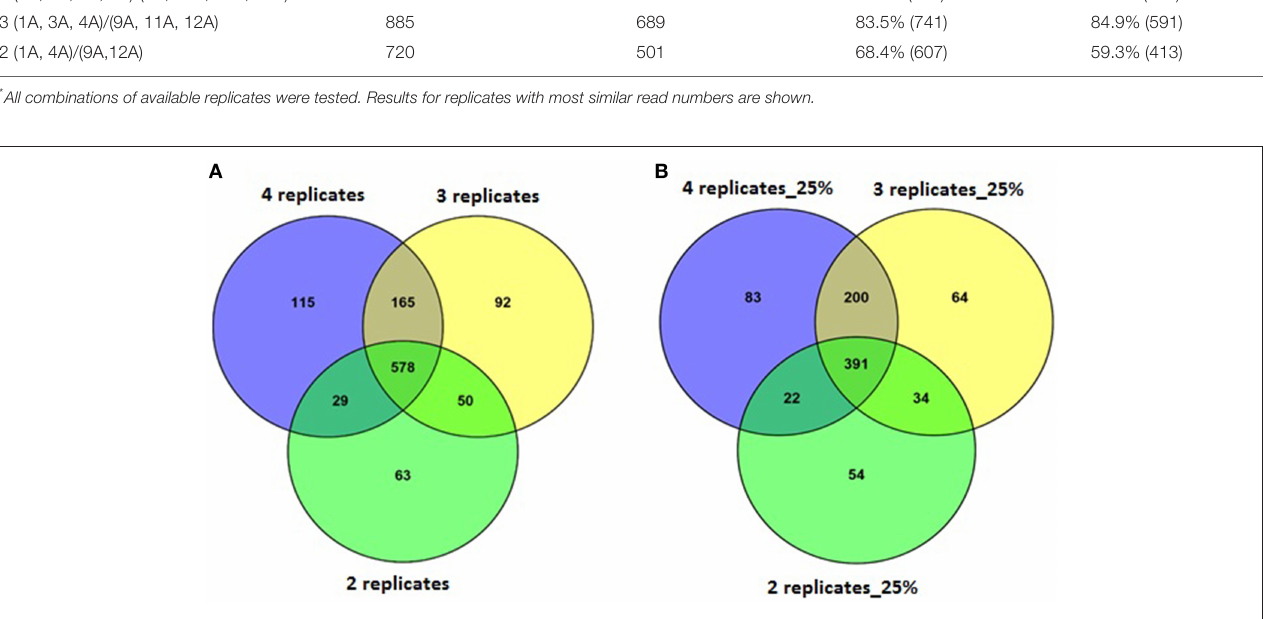
FIGURE 4 | Venn analysis of DE genes detected with varying replicate numbers. (A) Venn diagram depicting the effect of 2–4 replicates while maintaining 100% of the reads, on significantly differentially expressed genes and the genes commonly detected within sets of varying replicates for strain ATCC10792. (B) Venn diagram for differentially expressed genes detected with 25% reads ( ∼ 5–10M) and 2–4 replicates for strain